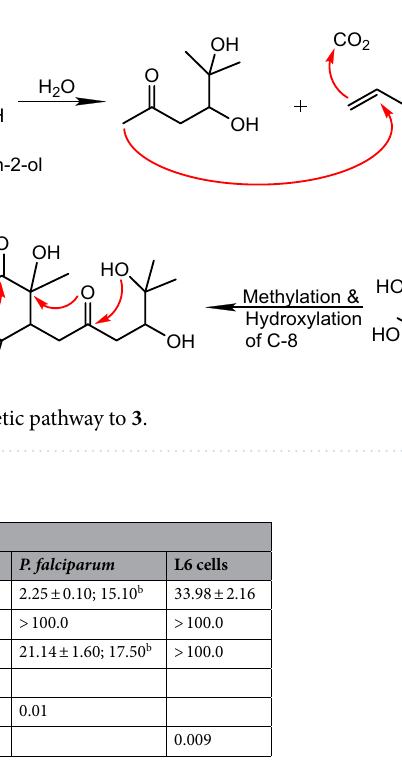
Table 3. In vitro activity of compounds 1–3 against T. b. rhodesiense (STIB900) and P . falciparum (NF54) and cytotoxicity in L6 Cells. a Average of at least two independents assays. b Selectivity index (SI): IC 50 in L6 cells divided by IC 50 in the titled parasitic